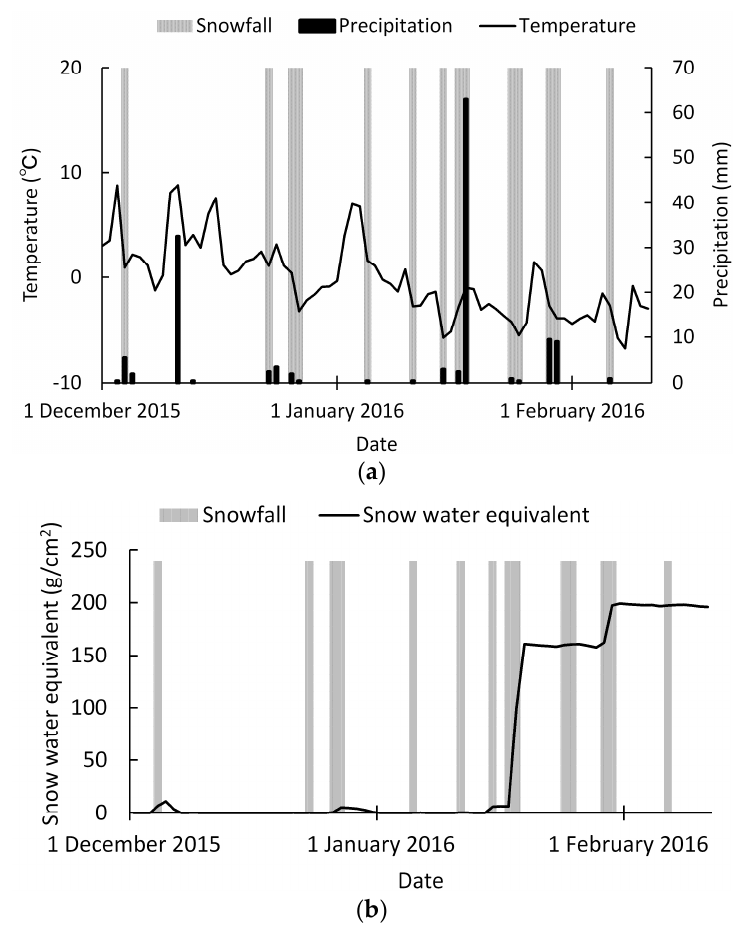
Figure 12. ( a ) Trend of temperature and precipitation at the closest observation points to the survey area; and ( b ) trend of the calculated snow water equivalent with the hydrological model at the point of P 1 that is shown in Figure 1.